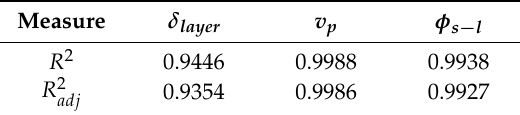
Table 2. Error testing of response surface models.